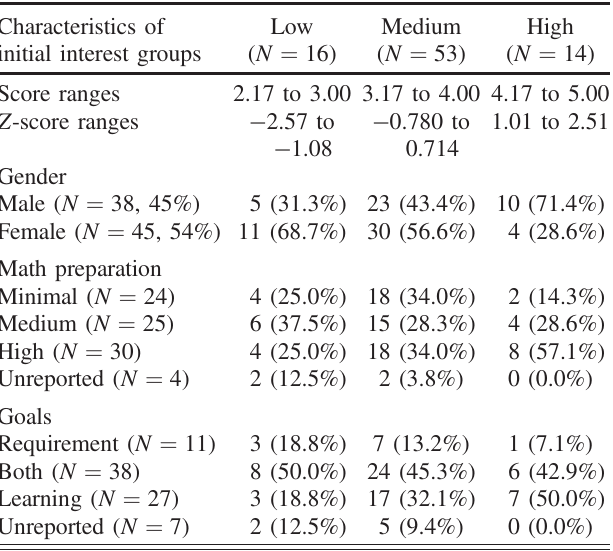
TABLE IV. Score ranges and number of individuals corre- sponding to initial physics interest groups, and gender, math preparation, and goals of each group. Each student ’ s interest score is the mean of his or her pre-IPLS responses to the six items in the Personal Application Factor, on a scale of 1 to 5 ( 1 ¼ strongly disagree, 5 ¼ strongly agree).